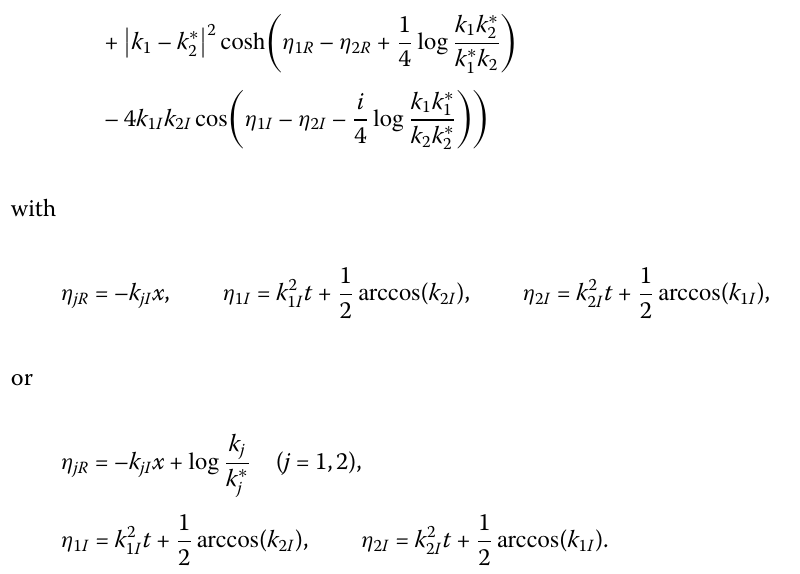
Figure 2 shows that the two-soliton solution is periodic with respect to time t and lo- calized in the x direction. Figure 2(a) illustrates the density distributions | q | 2 on the ( x , t )- plane and (b) expresses the interaction process of the two-soliton solution for η j 0 R = 0. Fig- ure 2(c) shows the density distributions | q | 2 on ( x , t )-plane and (d) describes the profiles of . It seems that the two-soliton solution for different times when the constants η j 0 R = log k j k ∗ j the constant η j 0 R influences the interaction process of the two-soliton and the two solitons are apart from each other. with the constants η j 0 R = log k j k ∗ j